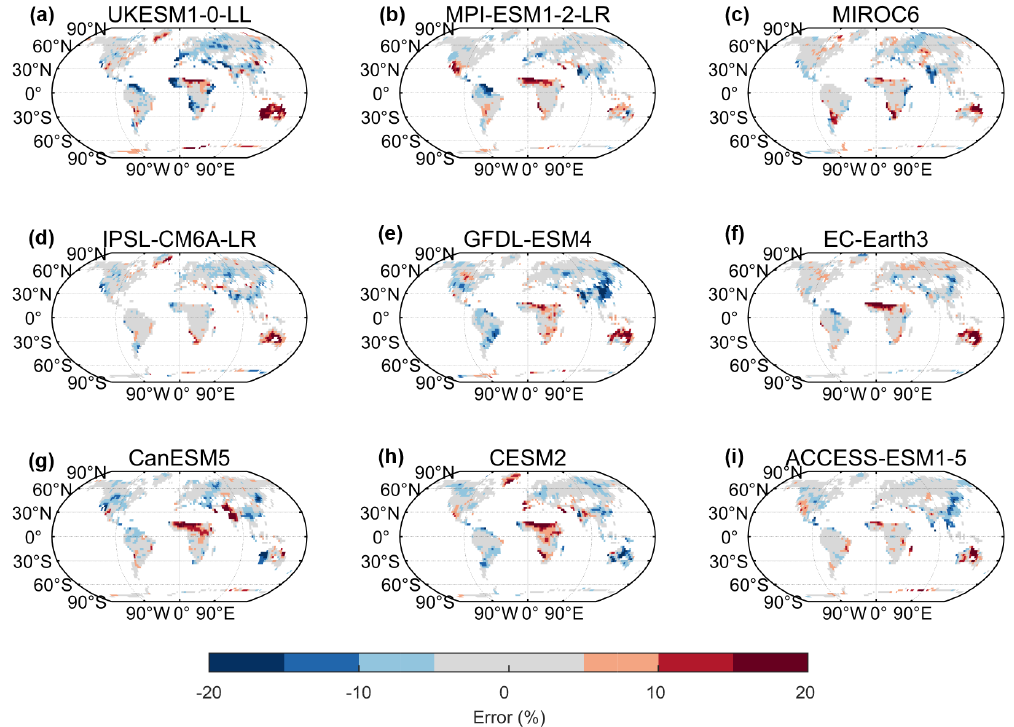
Figure 9. The spatial pattern of the error of the MAP in 2071–2100 between each ESM and emulation from PREMU under the SSP1–2.6 scenario: (a) UKESM1-0-LL; (b) MPI-ESM1-2-LR; (c) MIROC6; (d) IPSL-CM6A-LR; (e) GFDL-ESM4; (f) EC-Earth3; (g) CanESM5; (h) CESM2; (i)